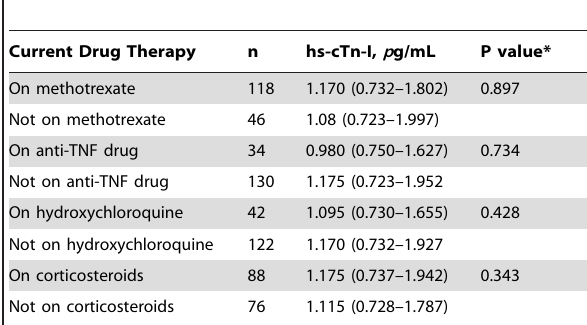
Table 3. Concentrations of hs-cTn-I in patients with RA receiving different drugs (n=164).